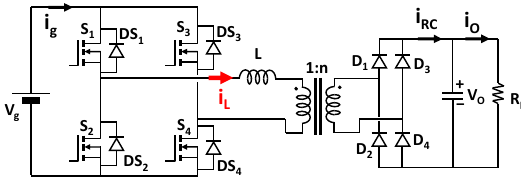
Figure 1. Single active bridge (SAB) converter.